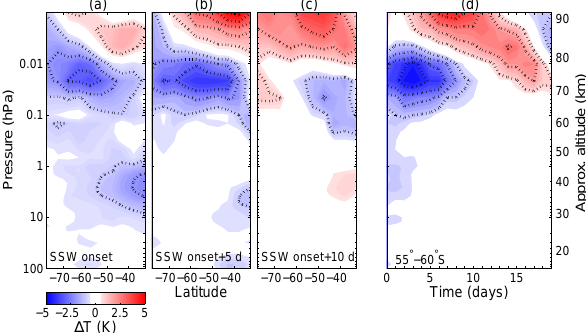
perature perturbations in the Southern Hemisphere, with averages starting at the day of the SSW onset, 5 days after the SSW onset, and 10 days after the SSW onset, respectively. (d) Time series showing the development of the 5-day moving average temperature pertur- bation at 55–60 ◦ S. The time is indicated relative to the start of the SSW onset. The colour scale used in Fig. 7 is equal for all panels, and temperature anomalies with a magnitude smaller than 0.5K are not shown for clarity. The ± 1, ± 2, ± 3, ± 4, and ± 5K contours are highlighted with a dotted